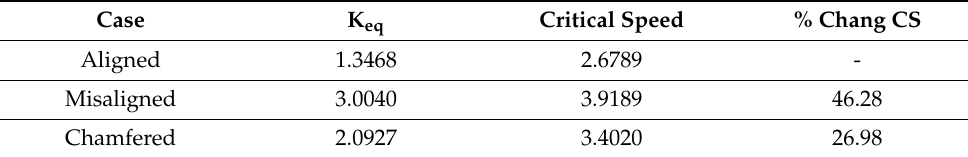
Table 2. Dimensionless critical speed and equivalent stiffness for different